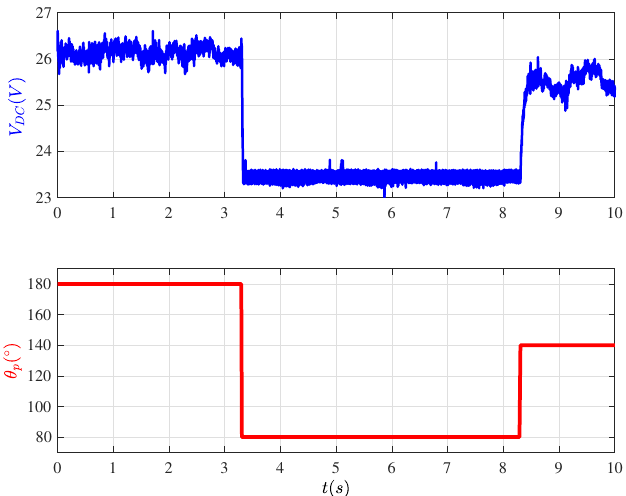
Figure 6. Influence of the conduction angle on the DC bus voltage. The other parameters are set to: I ref = 16 A, ψ = 180 ◦ , R L = 15 Ω , and ω = 800